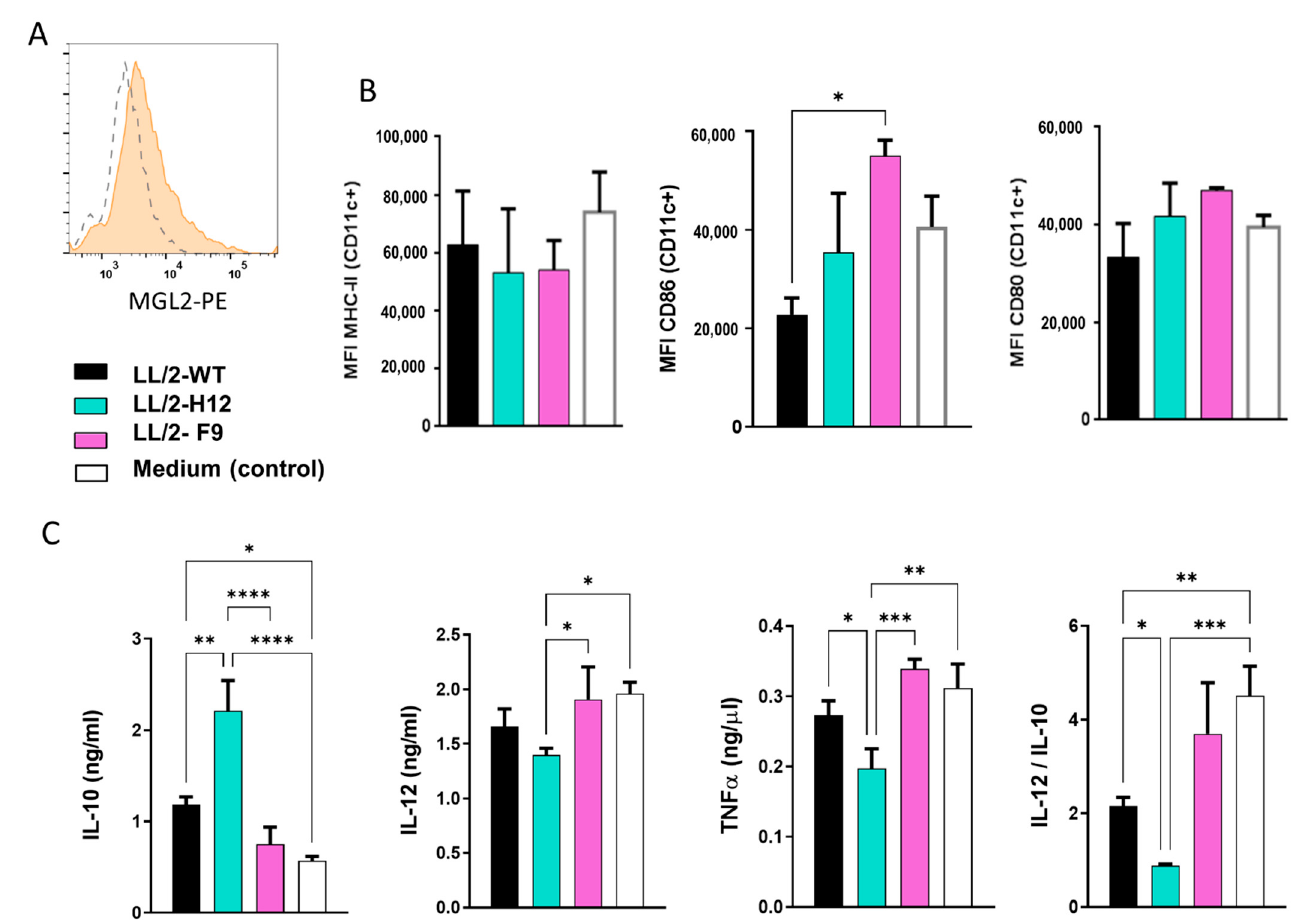
Figure 5. LL/2 derived-conditioned medium from Tn + cells differ in their ability to modulate BMDC function. BMDCs were incubated overnight with CM derived from LL/2-WT, Tn + -H12, and Tn + -F9 cells. ( A ) MGL2 expression on BMDC by flow cytometry. ( B ) Expression of MHC II, CD86, and CD80 on CD11c + MGL2 + BMDCs cultured with CM from LL/2 WT, Tn + -H12, and Tn + -F9 cells by flow cytometry. MFI indicates medium fluorescence intensity. ( C ) Cytokines (IL-10, IL-12, and TNF- α ) were determined on culture supernatants by ELISA. Left, IL-12 to IL-10 ratio. Asterisks represents significant differences (* p < 0.05, ** p < 0.01, *** p < 0.001, **** p < 0.00001). Moreover, CM from LL/2-Tn + -H12 cells induced the secretion of higher levels of IL- 10 as compared to CM obtained from LL/2-Tn + -F9 and WT tumor cells, while CM from LL/2-Tn + -F9 induced the secretion of higher levels of TNF α and IL-12 (Figure 5C). Finally,